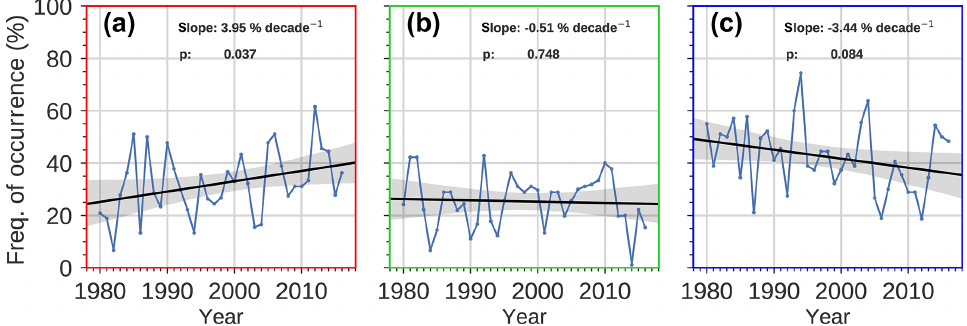
Figure 6. Frequency of occurrence for each transport pathway group according to the colouring (Fig. 1). The blue line shows the frequency of occurrence for each winter from 1979 to 2015. The black line shows the linear trend line. Greyshading shows the 95% confidence intervals for the trends derived via bootstrap resampling. p values according to a two-sided t test are shown in the respective panels.